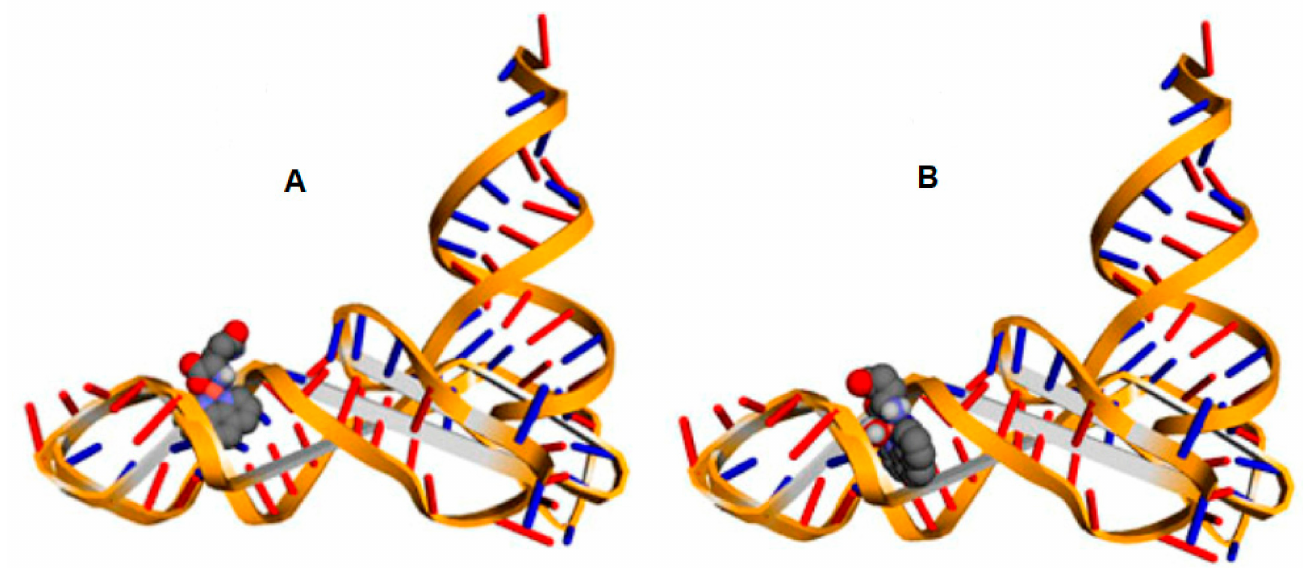
Figure 9. Docked structures of top molecular pose for: ( A ) anti-[Cu(L-Gln)(phen)(H 2 O]-6TNA and ( B ) syn-[Cu(L- Gln)(phen)(H 2 O]-6TNA.